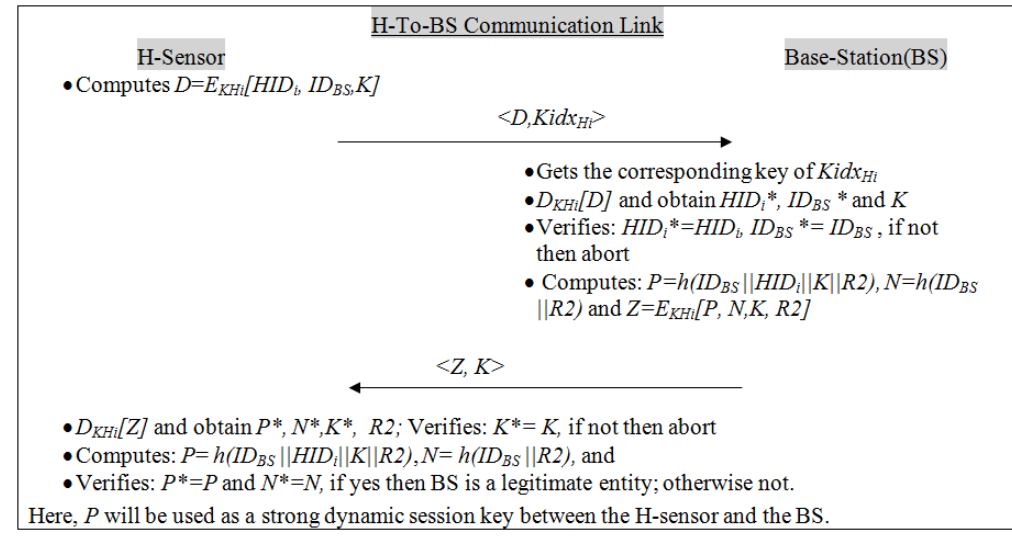
Figure 3. The messages flow of H-To-BS